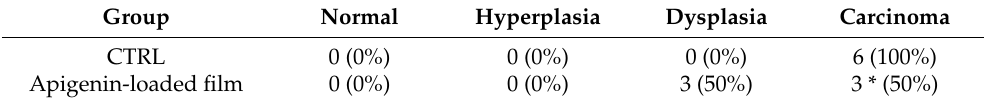
Table 4. In vivo histopathological assessments of rat tongues. * p < 0.05 vs. CTRL (chi-square test).